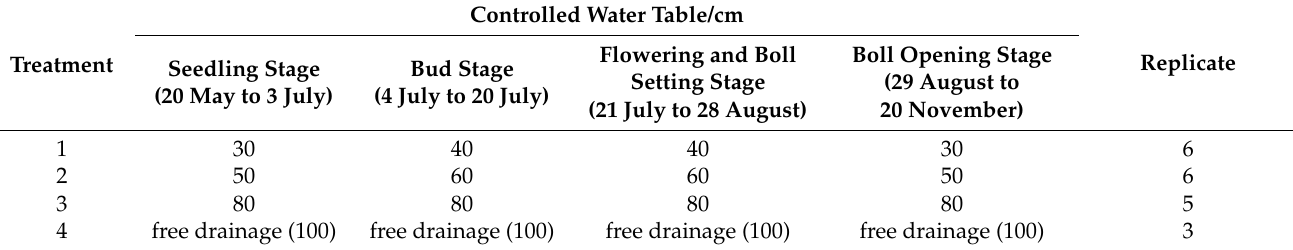
Table 2. Controlled water table design in the test